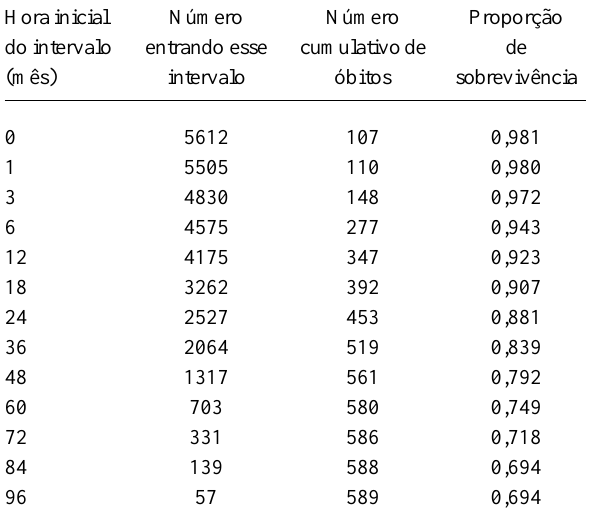
protocolo de acompanhamento, pois requer uma